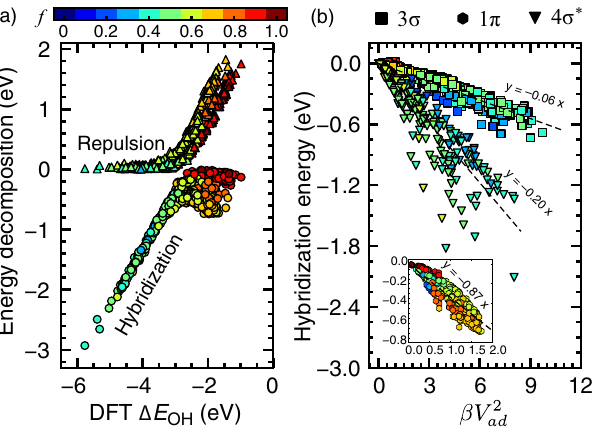
Fig. 4 Physical insights into chemical bonding. a Orbital hybridization and Pauli repulsion contributions from the metal d -states to the *OH adsorption energies on all 10-fold test sets deconvoluted by the TinNet models. b The TinNet-predicted coupling integral squared β V 2 ad for 3 σ , 1 π , and 4 σ * orbitals linearly correlate with the corresponding orbital hybridization energy ( R 2 : 0.93, 0.87, and 0.89, respectively). Regression lines with the intercept at 0 are shown. To avoid overlap, the 1 π data are plotted in the inset. All markers are color-coded according to the theoretical d -band fi lling f of the *OH adsorption